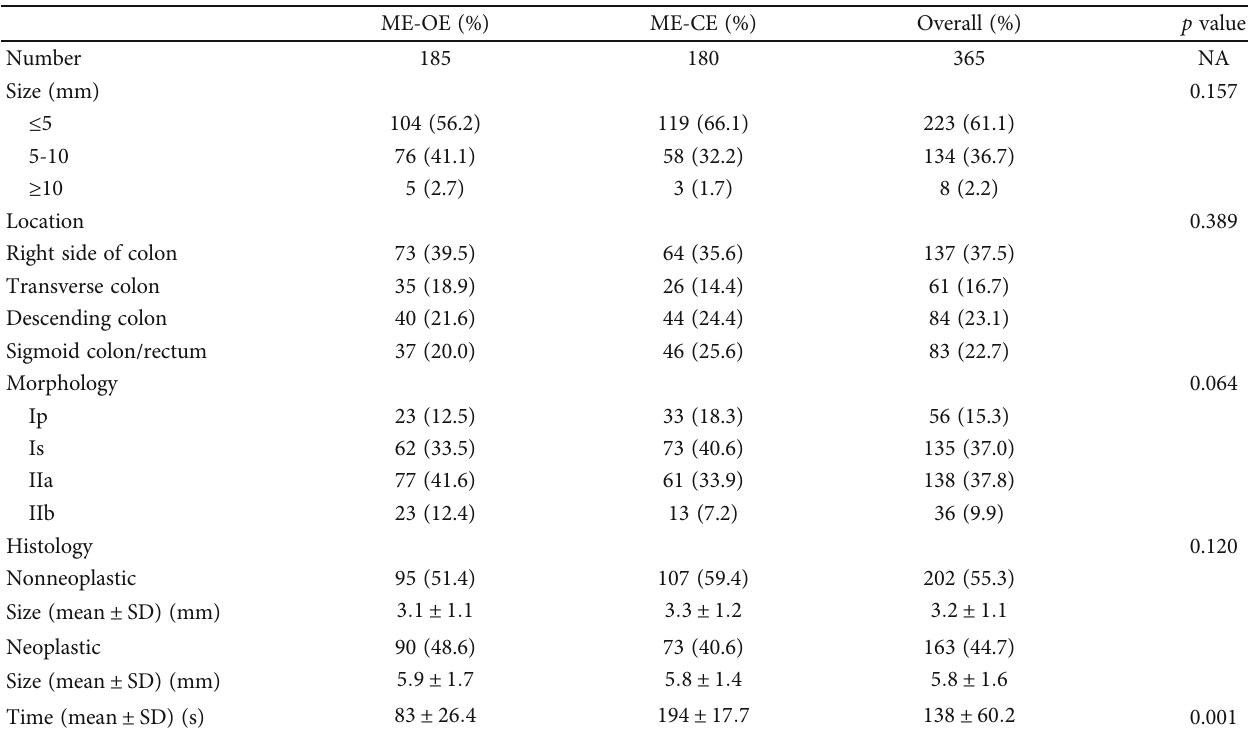
Table 2: Descriptive per-polyp analysis.